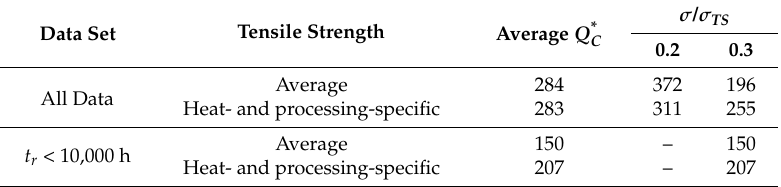
Table 2. Nimonic 105 Q ∗ values (kJ/mol) determined using Arrhenius plots. C